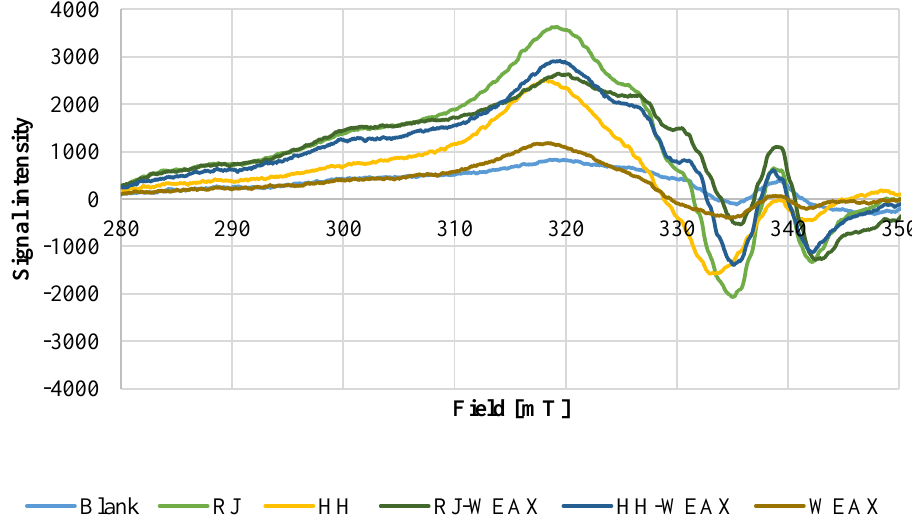
Figure 2. Cu 2+ -Ion chelating capacity, pH 7.4, incubation time 1 h.